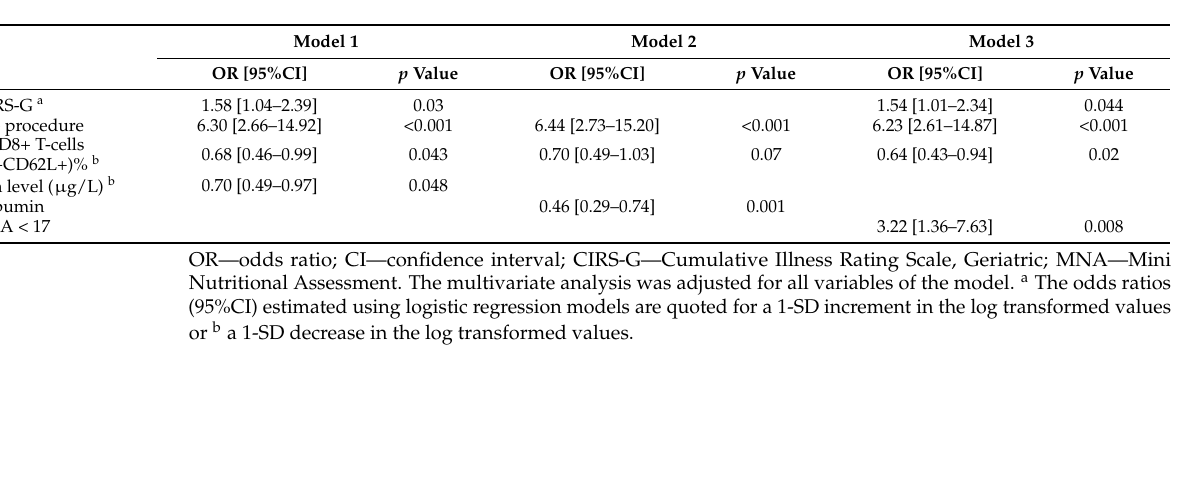
Figure 1. Adjustments for the ADL and CIRS-G scores; invasive procedures; serum CRP; serum albumin; the CD4/CD8 ratio; and the naïve CD8 T-cell, memory CD8 T-cell and effectors CD8 T-cell counts did not substantially change the relationship between the leptin level and the occurrence of HAIs. Table 4. Multivariate analyses of women with at least one healthcare-associated infection vs. women without infections (n =